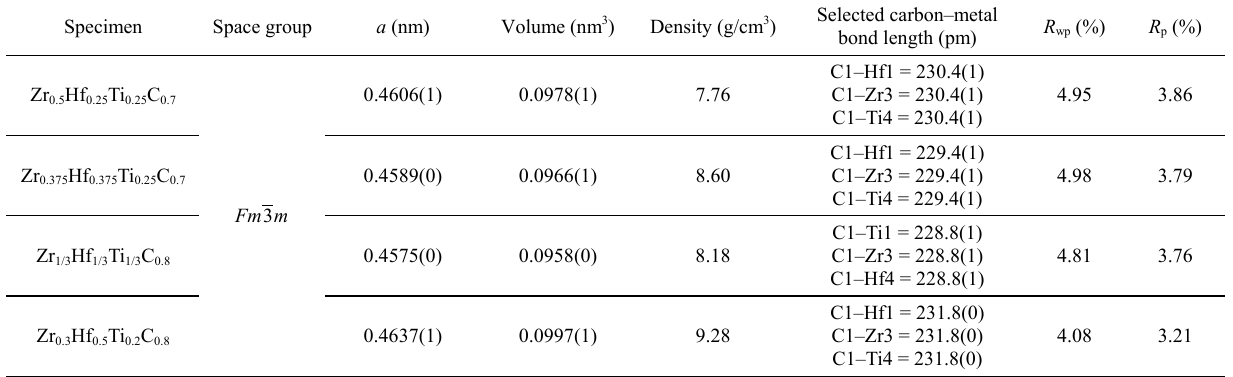
Table 1 Crystal structure parameters of carbides from Rietveld refinement of XRD